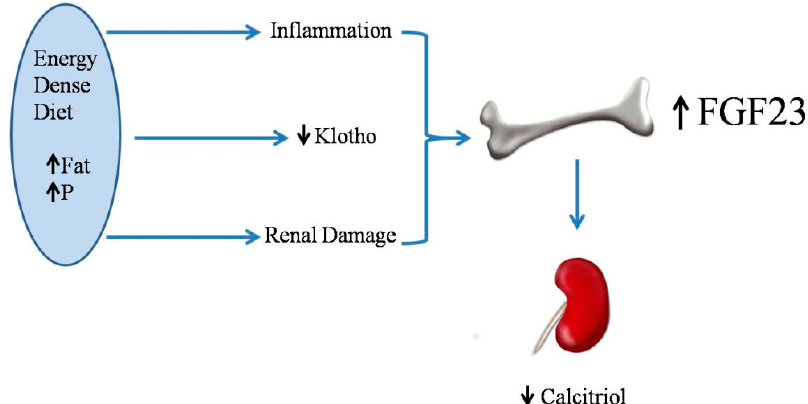
Figure 3. Energy-dense diets increase fibroblast growth factor 23 (FGF23) synthesis and secretion which in turn decreases calcitriol production. Phosphate: P.